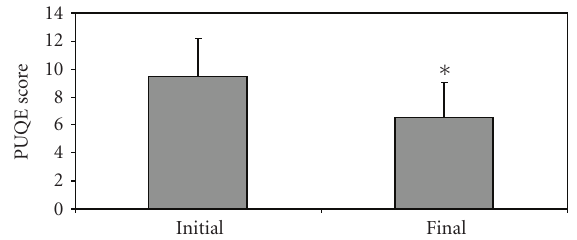
Figure 1: PUQE scores of women experiencing HB/RF and NVP at initial call and at follow-up after the use of acid-reducing pharmacotherapy; Final (marked “ ∗ ”): P < . 0001, compared to control.